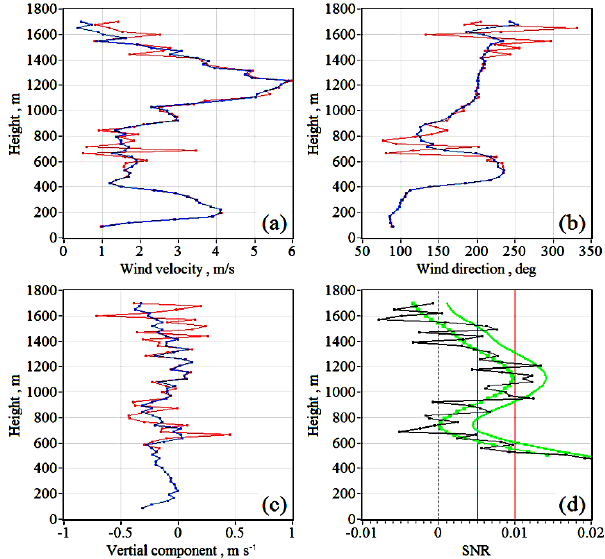
Figure 2. Height profiles of wind velocity (a) , wind direction an- gle (b) and vertical component the wind vector (c) retrieved from data measured by the Stream Line lidar, using LSM (red curves) and FSWF (blue curves); (d) : height profiles of signal-to-noise ra- tio estimates SNR (black curve), SNR s (green squares) and SNR c (green solid curve).